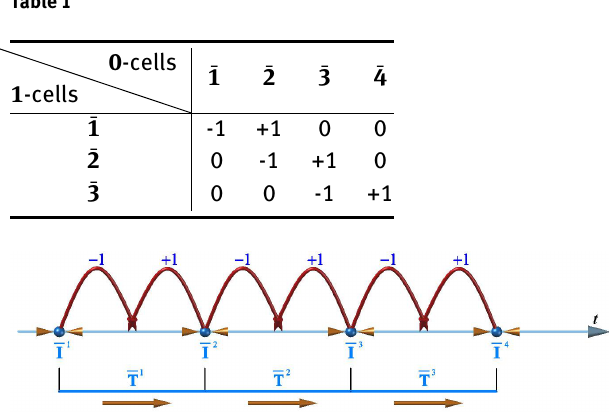
Figure 11: Inner orientations of the primal time elements for the case of four time